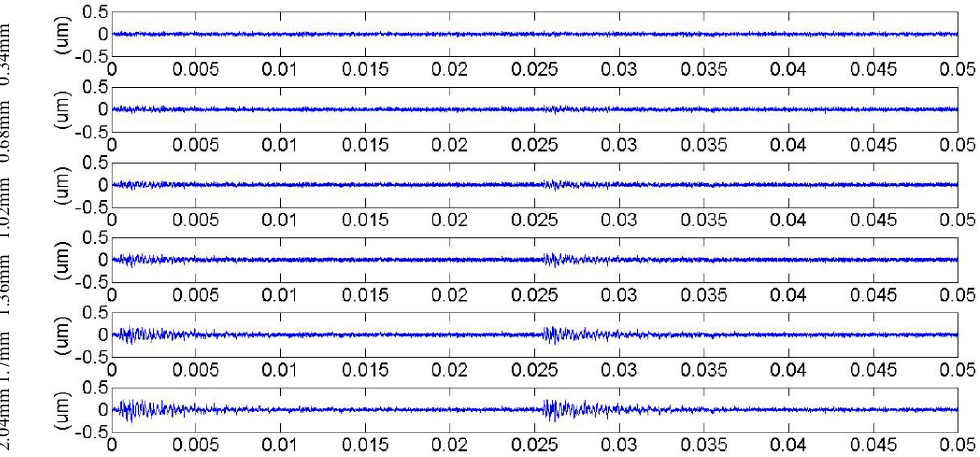
Figure 27. Vibration response of cracked gear at gear number 40/40.